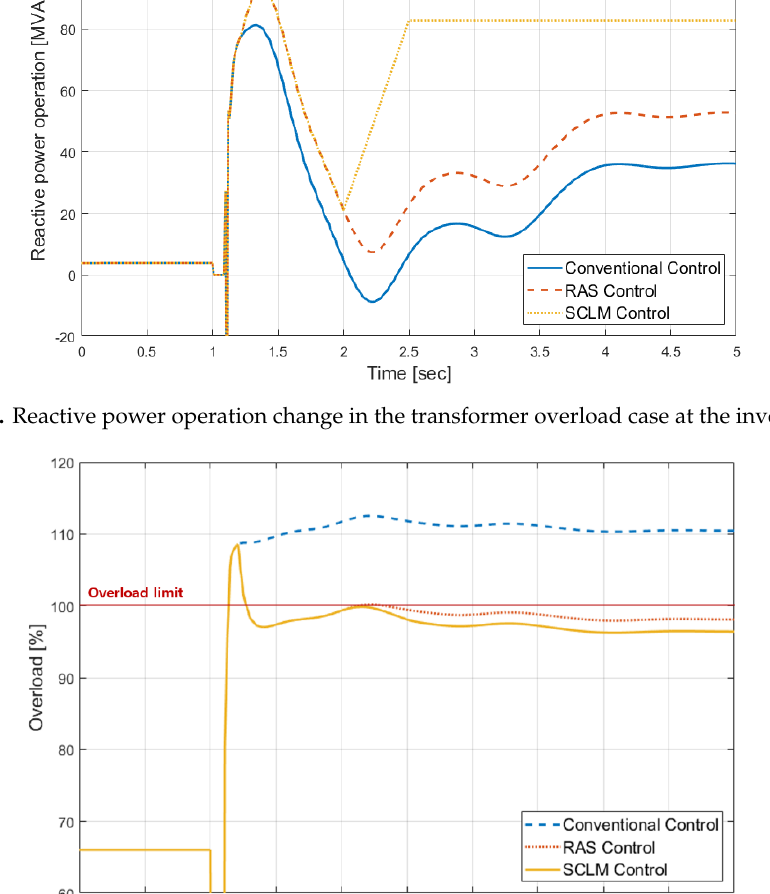
Figure 11. Comparison of HVDC control for overload mitigation in the transformer overload case. Table 7. HVDC setpoint change using the SCLM control for the transformer overload.